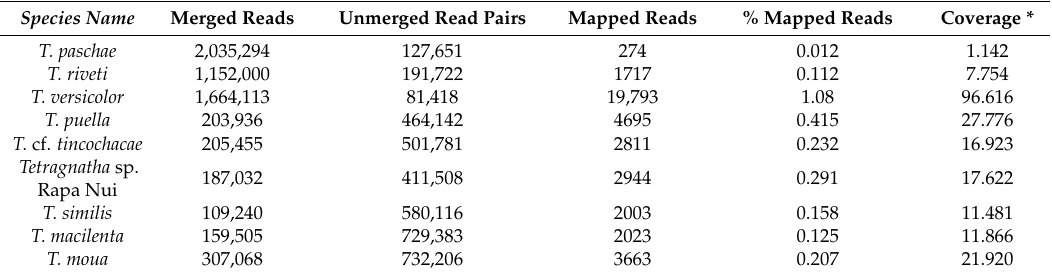
Table 2. Species included on the